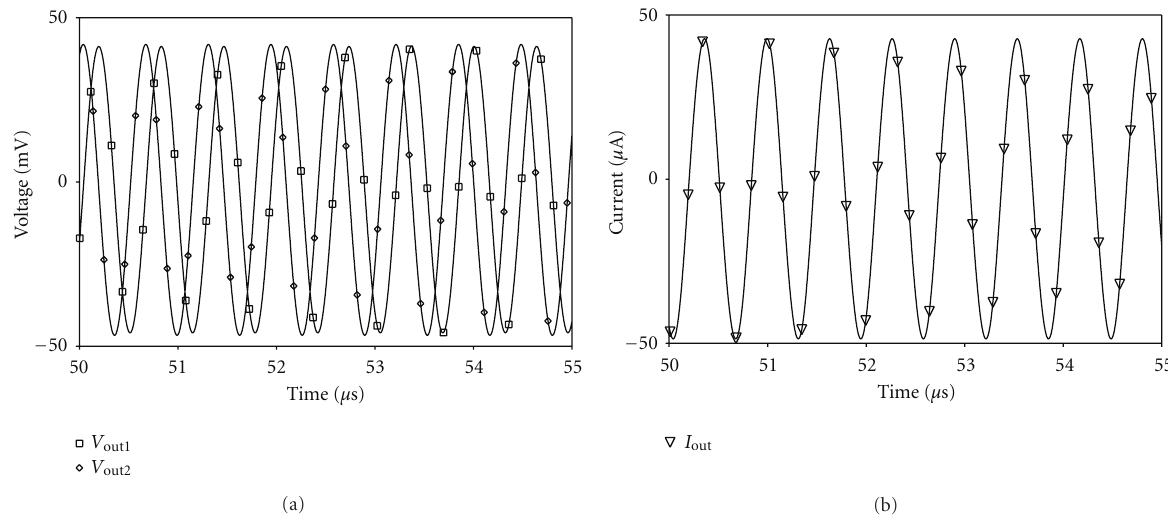
Figure 11: Outputs of the proposed oscillator: (a) quadrature output voltages at V out1 and V out2 ; (b) current oscillation at I out .